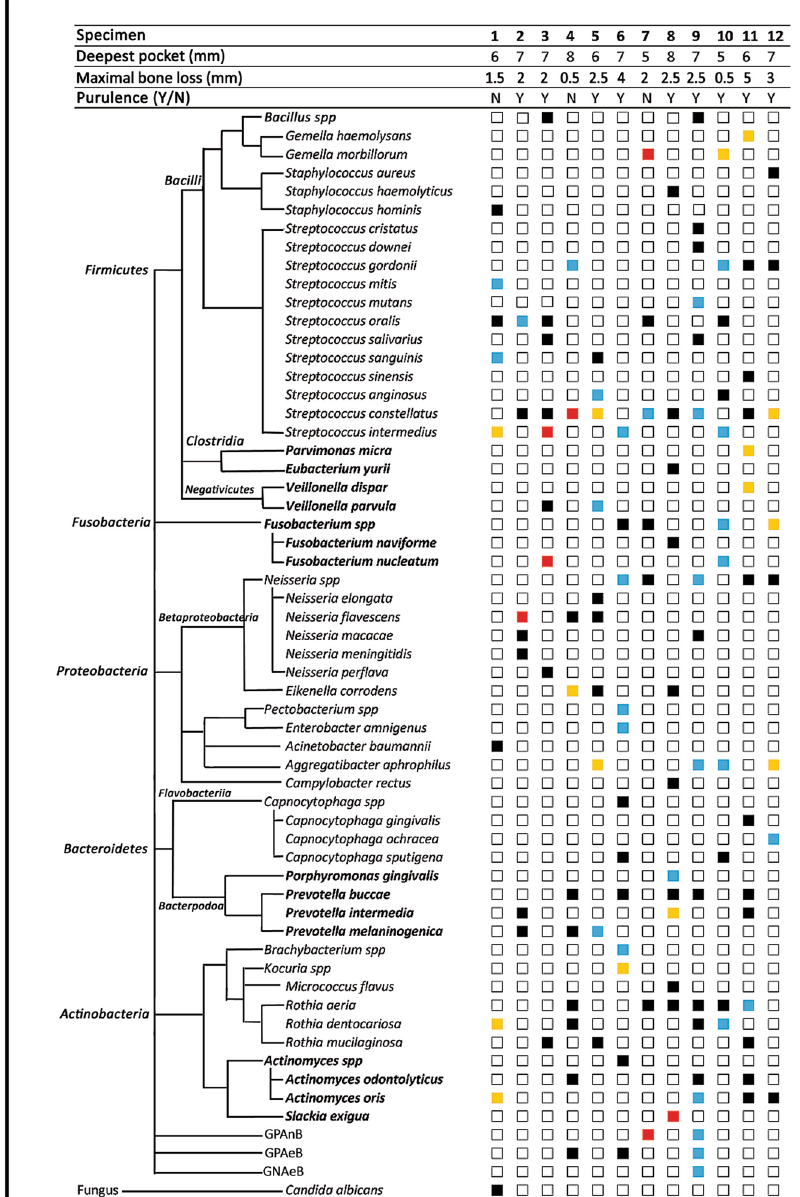
Figure 1. Microbial strains detected by MALDI-TOF MS from peri-implantitis pockets are shown in phylotypes. The percentages of microorganisms were calculated based on the individual sample. The percentages (p) of microbiota in each specimen were arbitrarily divided into different ranges and were marked with different colors, including black (p ≤ 5%), blue (5% < p ≤ 20%), yellow (20% < p ≤ 40%) and red (p >